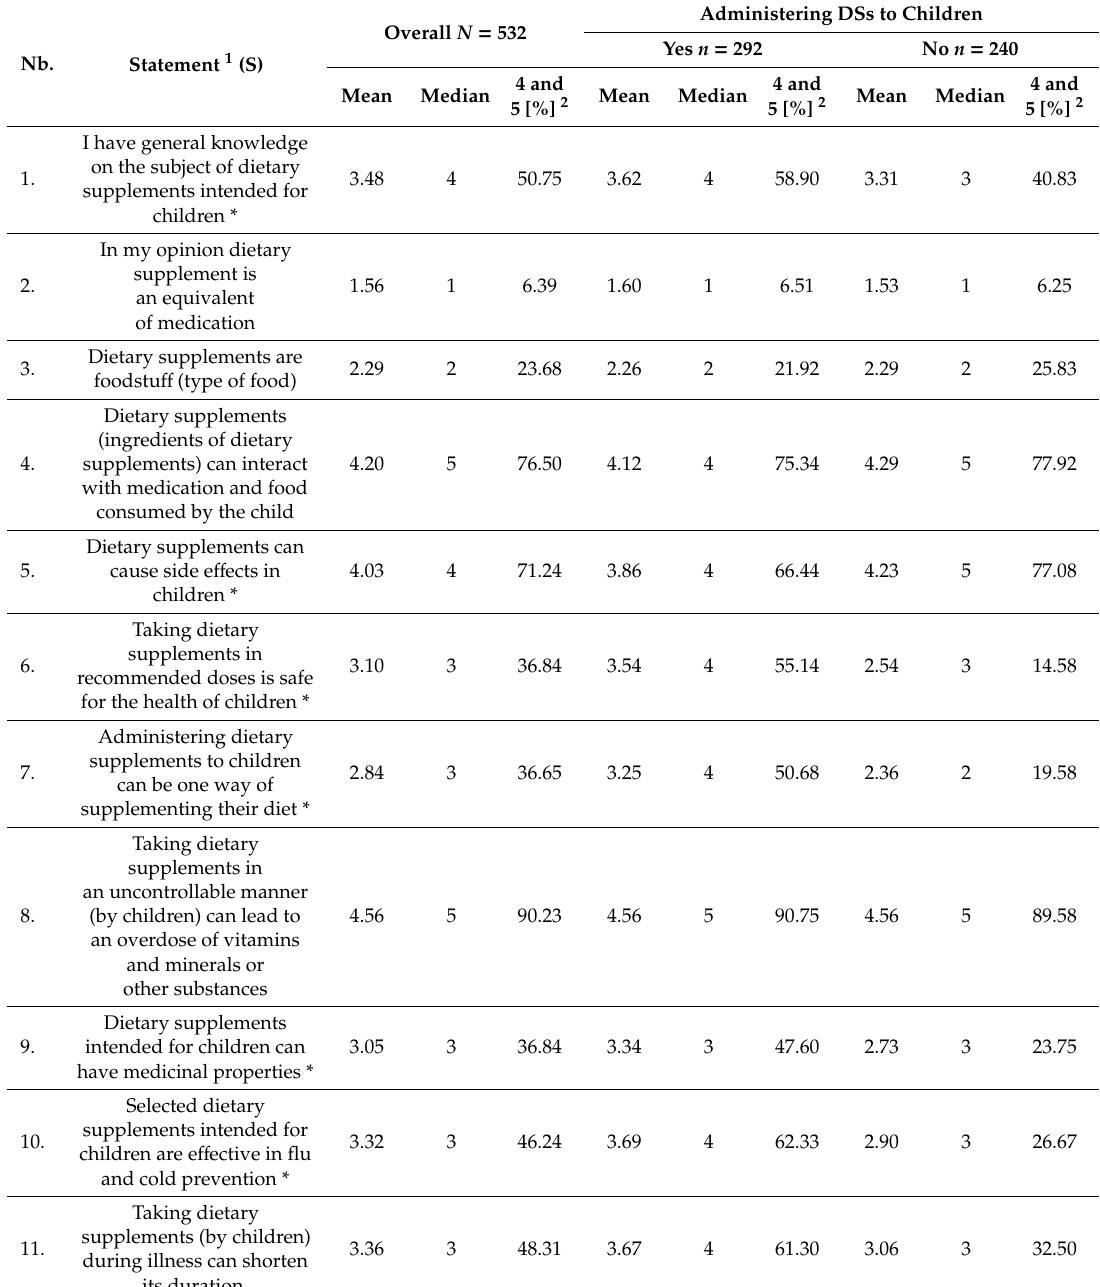
Table 3. Evaluation of the knowledge and attitudes of the respondents towards administering dietary